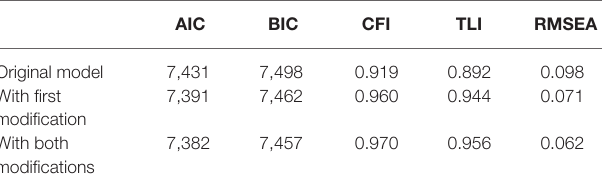
TABLE 3 | Effect of model optimization on fit